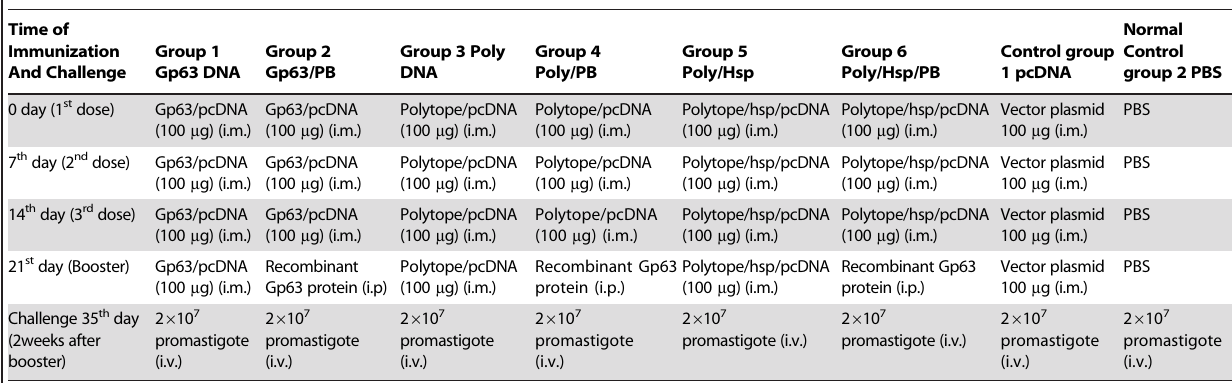
Table 1. Vaccination schedule for immunogenicity and efficacy studies in BALB/c mice.